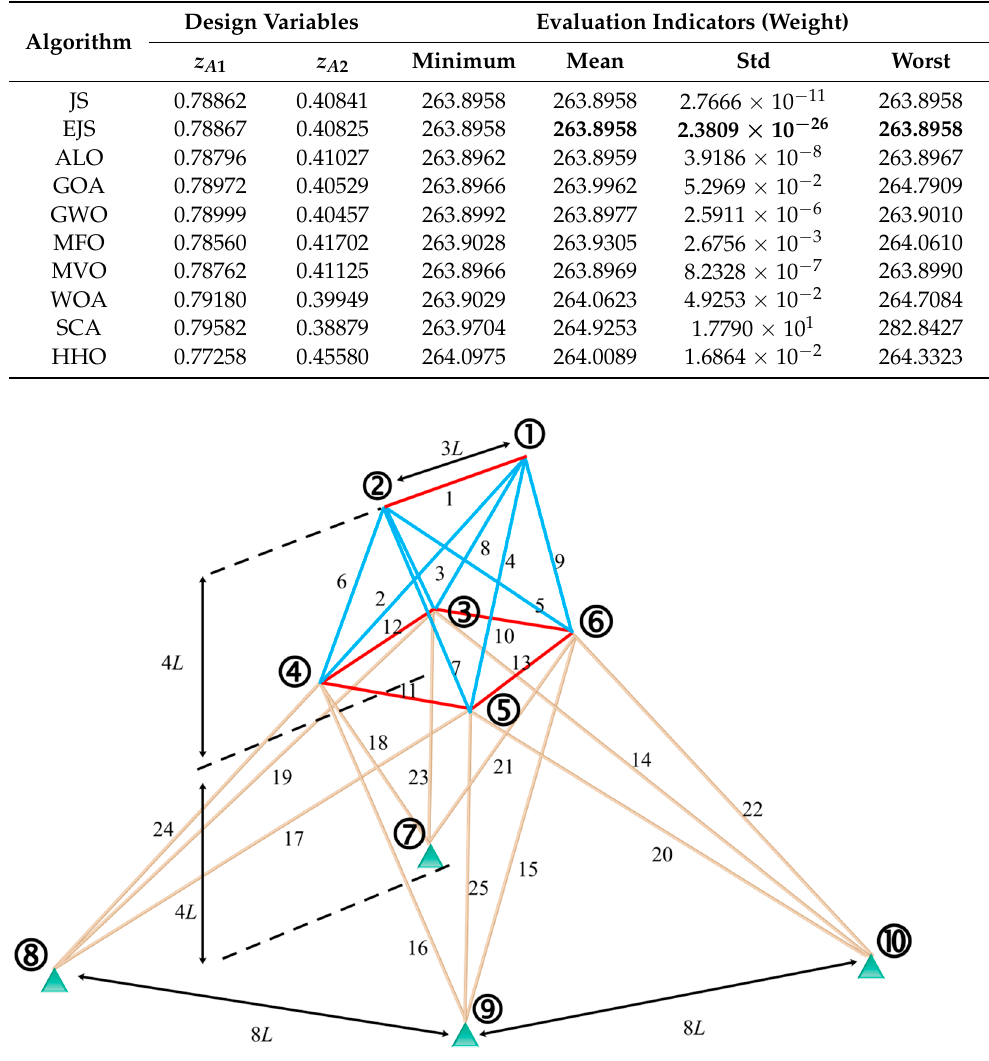
Figure 13. Sketch map of the spatial 25-bar truss design problem [21]. Table 11. Evaluation indicators and the variable values for Figure 13.